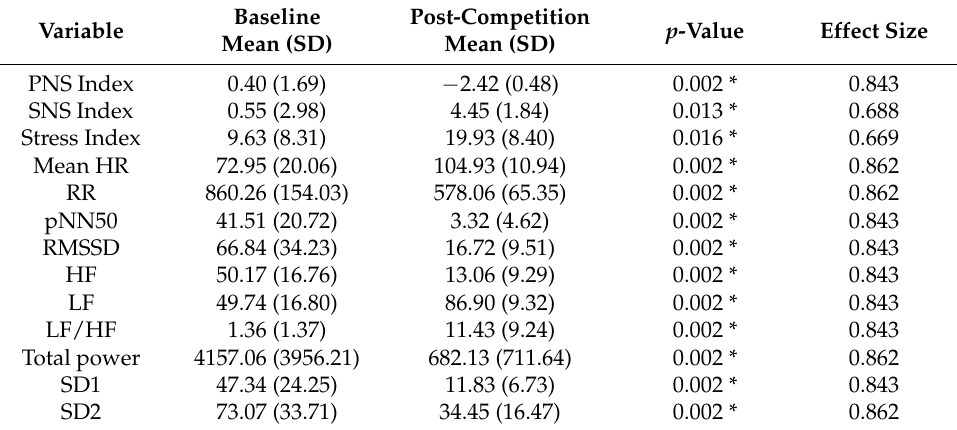
Table 2. HRV at baseline and after losing a soccer match for female soccer